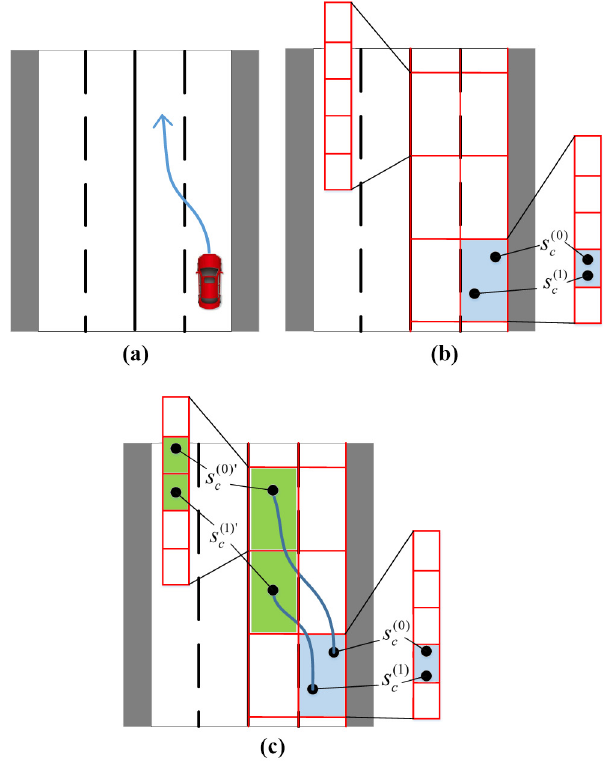
Figure 3 State space sampling and